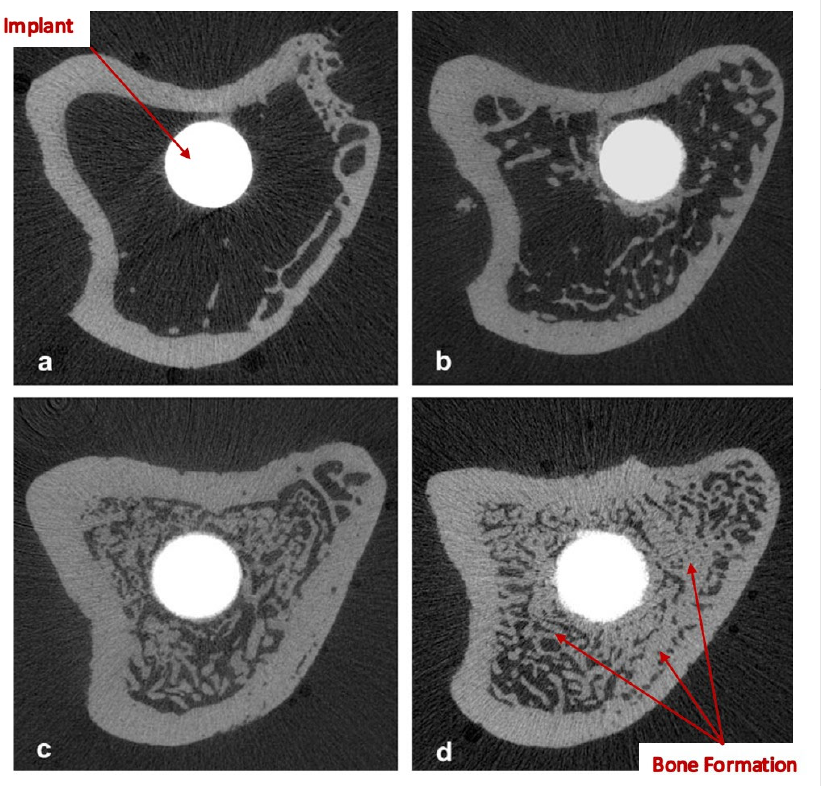
Figure 4. Micro-CT binary images of tibiae with implants 3 months after implantation: ( a ) uncoated implant; ( b ) Pamidronate; ( c ) Ibandronate; ( d ) Zoledronate [32].